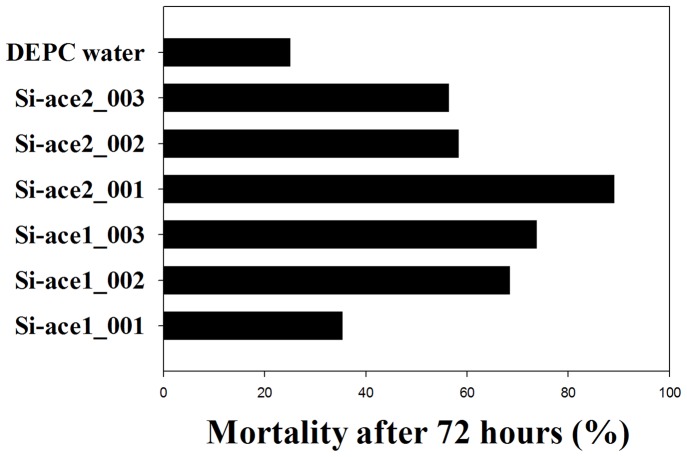
Mortality caused by chemically synthesized siRNA against second-instar larvae of Plutella xylostella, assessed by feeding test after 72 hour.